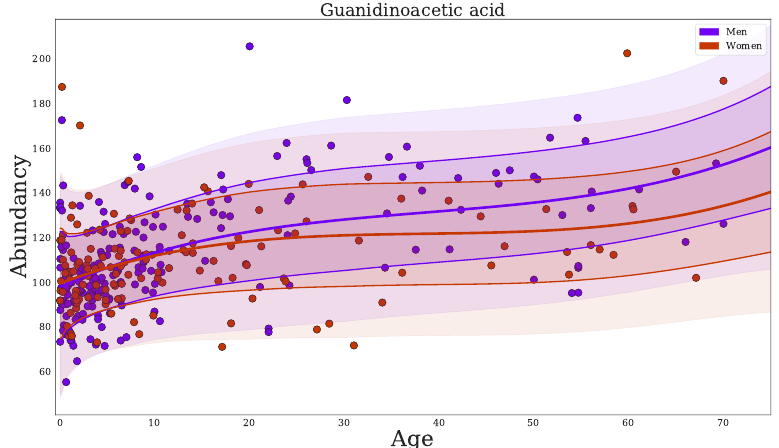
Figure 3. Regression of guanidinoacetic acid when using BC-Metchalizer normalized data. The dif- ferent colors indicate the sex as shown in the legend. The thick red/blue line indicates the average obtained from the fit on all samples for a given sex. The first standard deviation is indicated by the thin(ner) line whereas the second standard deviation ends at the shaded